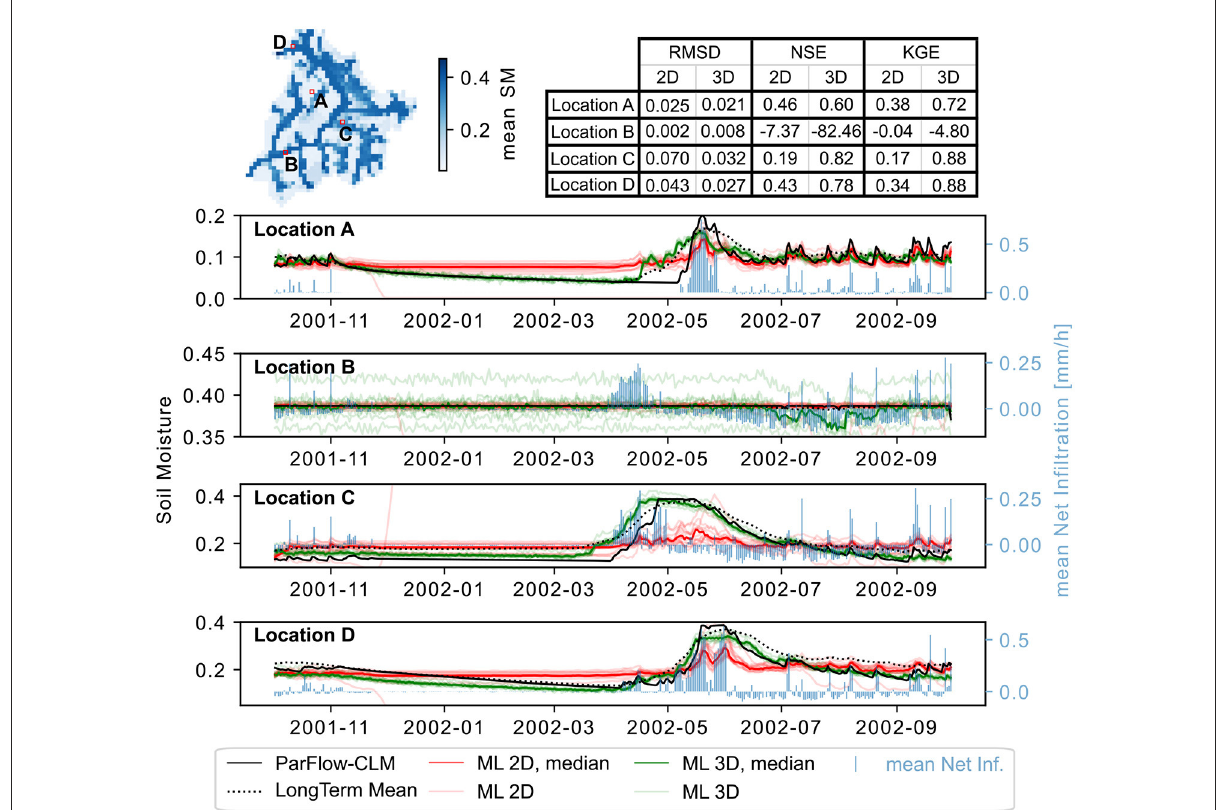
FIGURE7 Soil moisture timeseries at the 4 locations (A, B, C, and D) identified in the map of average Parflow-CLM soil moisture for the water year 2002. These are arbitrary locations selected to show the model behavior at different locations (e.g., B is on the river network, D is upstream, A is further from the river network, and C is next to an upstream contributor). The timeseries of ParFlow-CLM (continuous black line) are compared to the estimates with a 2D convolutional neural network (2D) and a 3D convolutional neural network. The semi-transparent lines represent the different ML models trained (different weight initialization), while the darker lines show the median of those lines for the 2D and 3D models. The corresponding performances are reported in the Table. The dashed line represents the long term mean timeseries of soil moisture simulated by ParFlow-CLM at each location, computed over the 36 years available (i.e., for each day, the mean over the 36 years for that